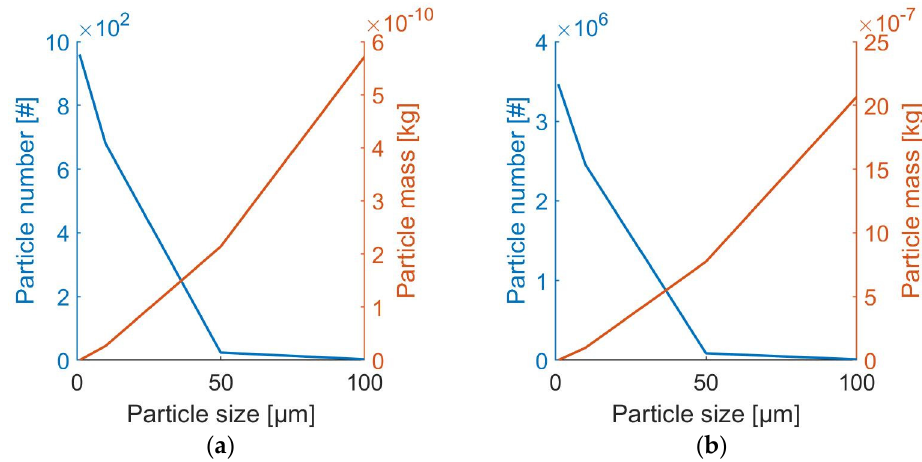
Figure 3. ( a ) PSD of section (800 × 600 µm²); ( b ) PSD of total area of the